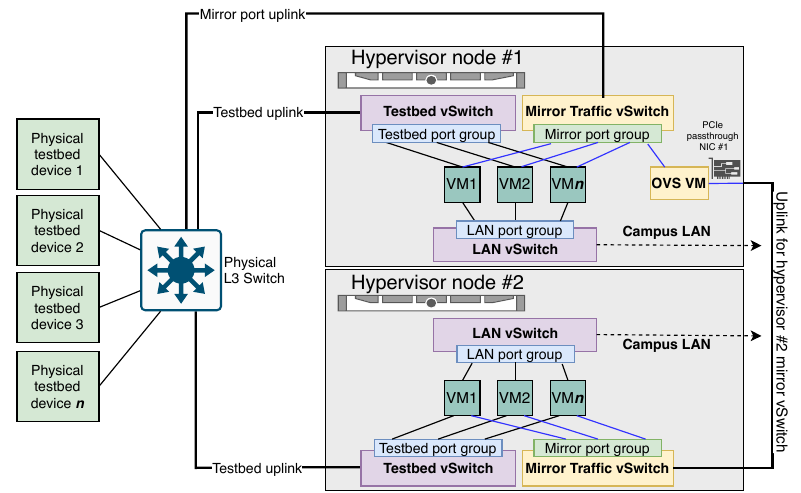
Figure 8. Cyber range infrastructure, with shared network mirror support (student VMs in green). The OVS VM is in charge of bridging traffic between the vswitches that form the virtual network used to distribute the network mirror across the hypervisor nodes (depicted in yellow). To achieve this, the OVS VM has native access to one of the physical